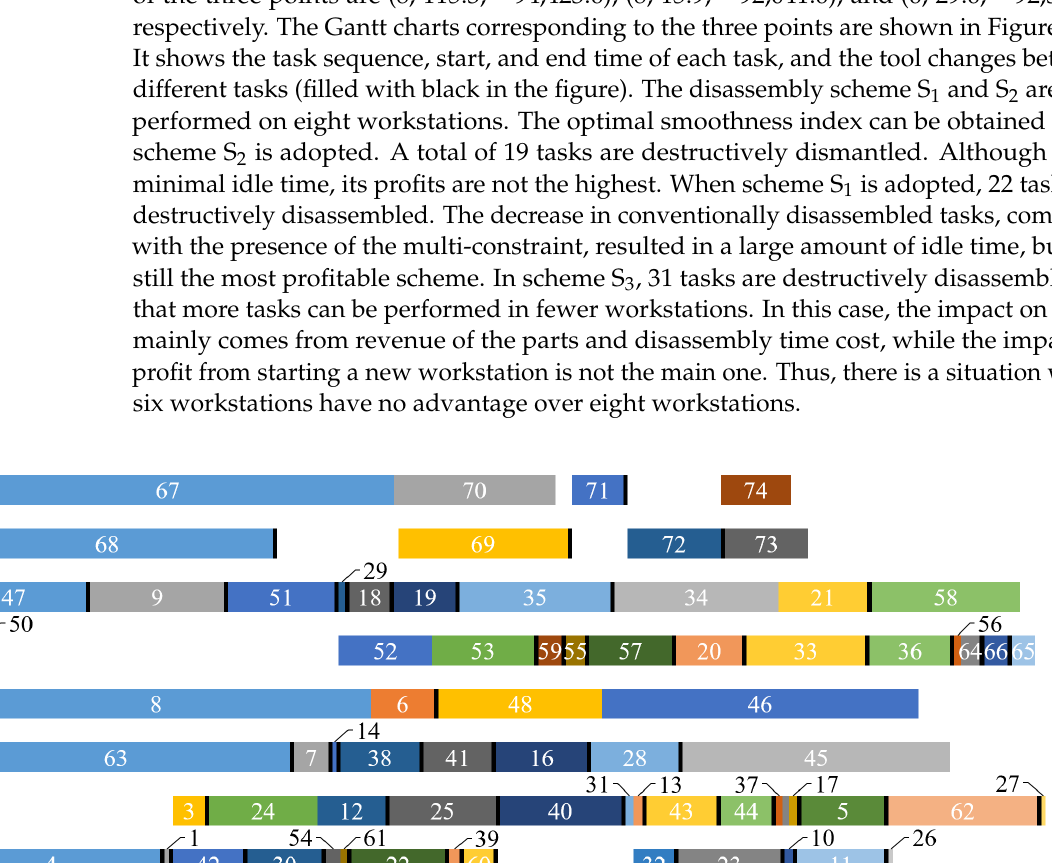
Figure 8. Gantt chart of disassembly scheme S 2 .